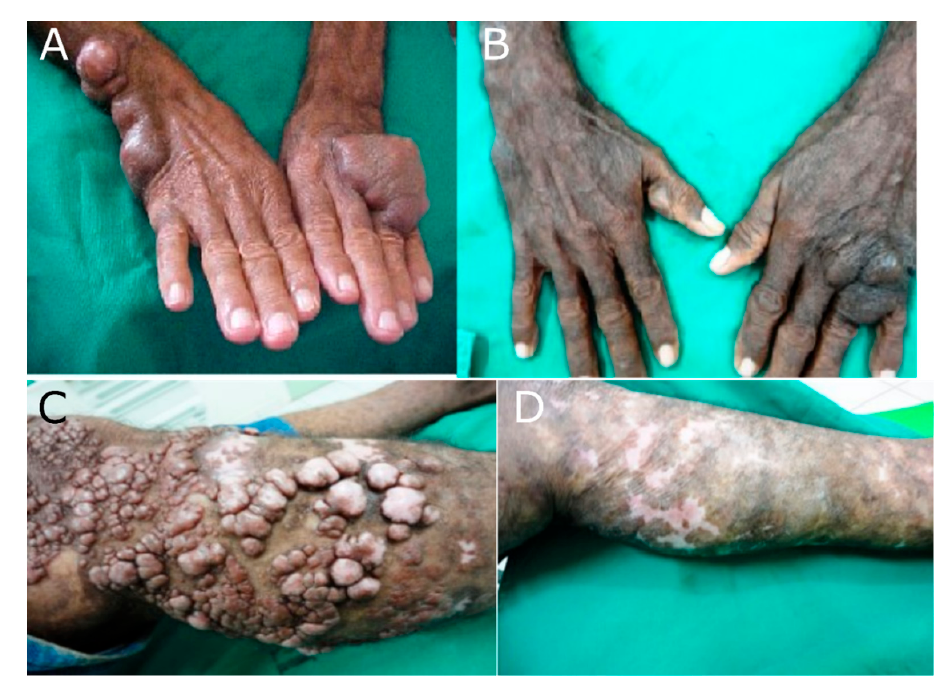
Figure 1. WHO/MDT/MB standard protocol for lobomycosis treatment, SDPA, Acre state, 2020 [71]. ( A ) localized lobomycosis before and ( B ) after WHO/MDT/MB treatment for four years. ( C ) disseminated lobomycosis before and ( D ) after WHO/MDT/MB treatment for four years plus lesion resection twice a week for one year.